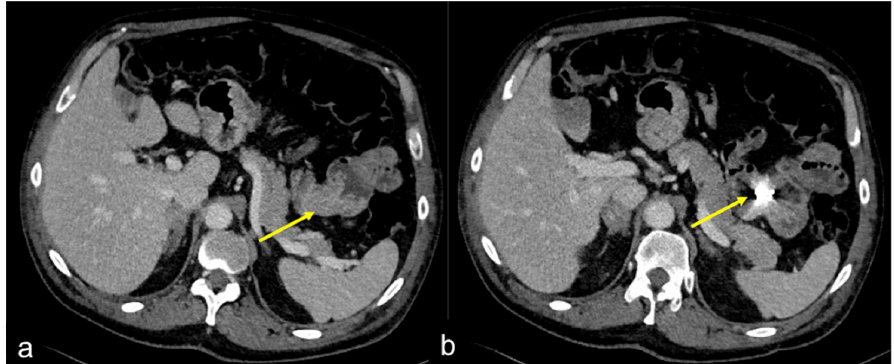
Figure 29. CTA study in venous phase ( a ) of jejunum adenocarcinoma shows a substenosing solid mass in the lumen of the jejunum (arrow); the successive check after endoscopic haemostasis ( b , arrow).